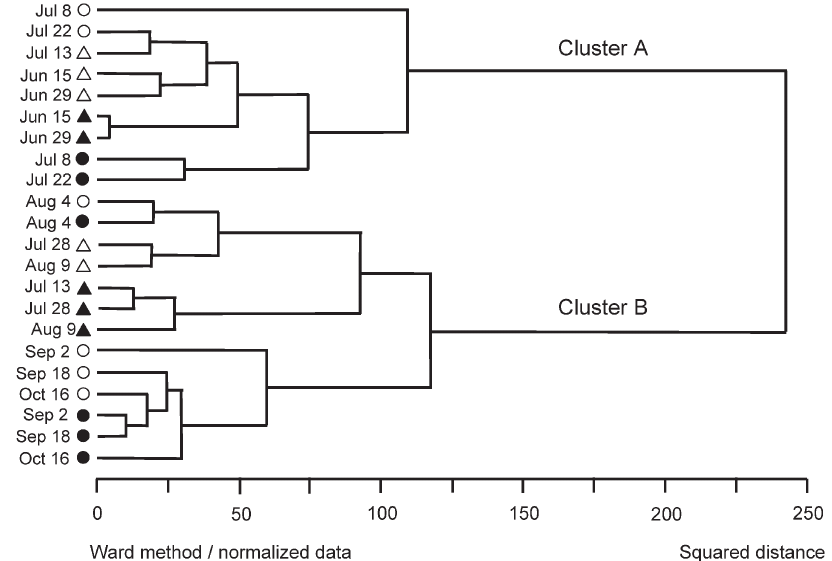
Figure 2. Cluster analysis of DGGE patterns of methanogenic archaeal communities associated with rice straw decomposition. Symbols: (cid:2) = sheath in Experiment 1; (cid:3) = sheath in Experi- ment 2; (cid:4) = blade in Experiment 1; and (cid:5) = blade in Experiment 2.